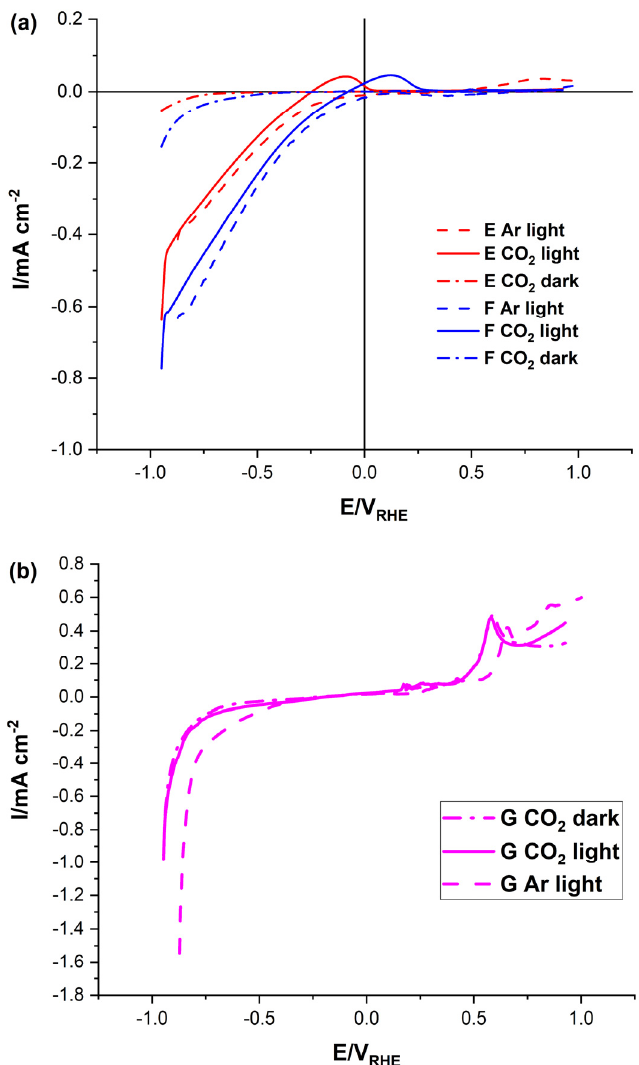
Figure 8. Photocatalytic current − potential curves of TiO 2 ‐ coated p ‐ GaP/Si photocathode samples ( a ) E, F and ( b ) G in 0.5 M NaCl and 10 mM pyridine solution saturated with Ar or CO 2 measured under AM1.5 irradiance and in the dark. Potential replotted with respect to reversible hydrogen electrode (RHE).